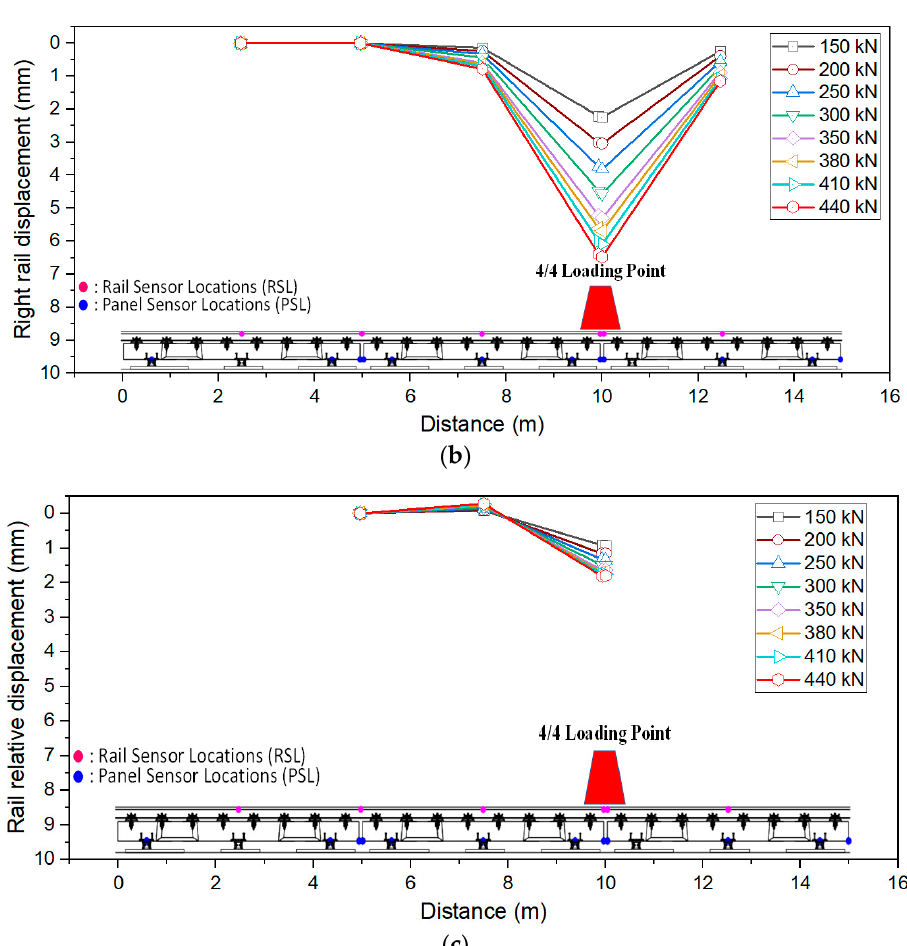
Figure 12. Vertical displacement results for three-panel testing (at 2nd panel 4/4 loading point), ( a ) vertical displacement of the panel (mm), ( b ) vertical displacement of the right rail (mm), and ( c ) rail relative vertical displacement (mm).